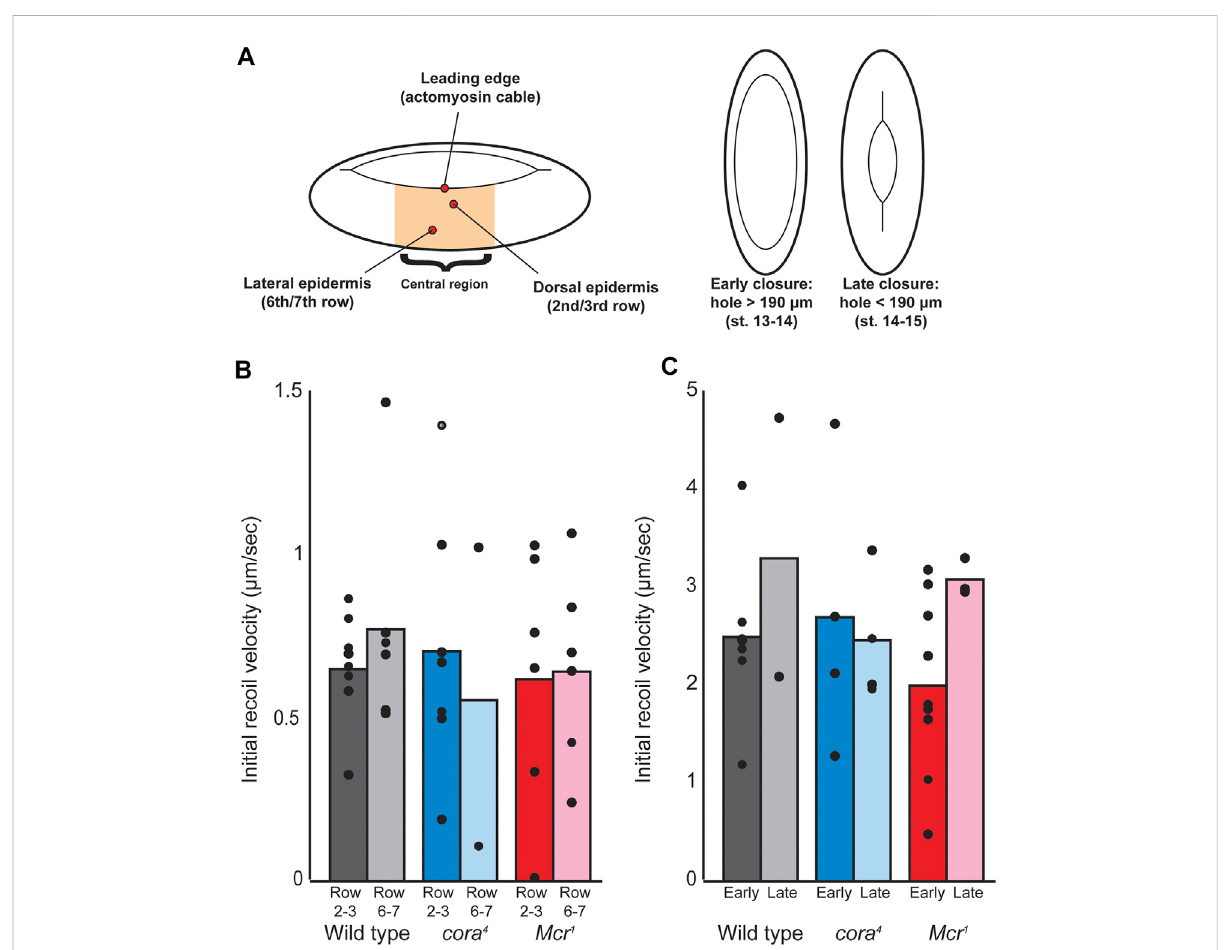
FIGURE 6 Laser ablation of cell junctions during dorsal closure. (A) Laser ablation scheme. Single cell junctions were ablated within the central region of the embryo during dorsal closure at three different locations, including the dorsal epidermis (second or third row of cells from the leading edge), lateral epidermis (sixth or seventh row of cells from the leading edge), and actomyosin cable (along the leading edge), and both early and late timepoints. Timepoints were determined based on the dorsal hole length (canthus to canthus), with dorsal holes > 190 μ m considered “ early ” and dorsal holes < 190 μ m considered late. (B) Initial recoil velocity of tricellular junctions neighboring the cut junction at both dorsal and lateral epidermal regions during late closure. Nosigni fi cant differences were observed either across genotypes or across locations. (C) Initial recoil velocity of tricellular junctions neighboring cell junctions cut along the leading edge at both early and late timepoints. Differences between genotypes and between timepoints were not signi fi